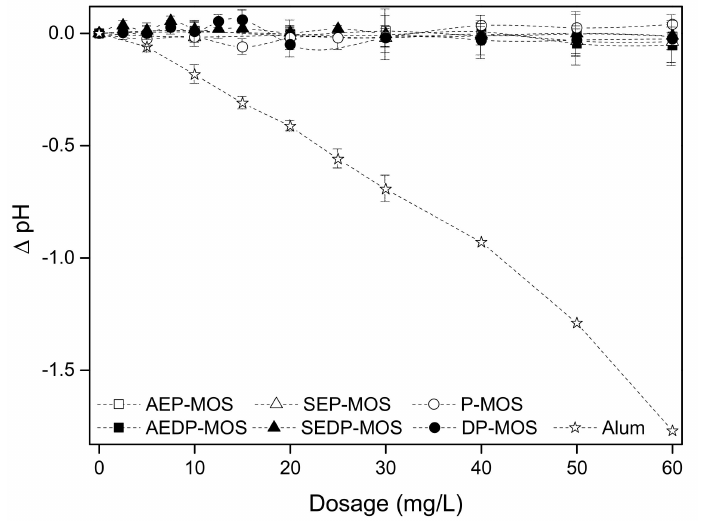
Figure 4. pH variation as a function of Moringa oleifera seed-derived and alum coagulants dosages in jar tests after coagulation, flocculation, and sedimentation. Initial pH was 7.10 ±